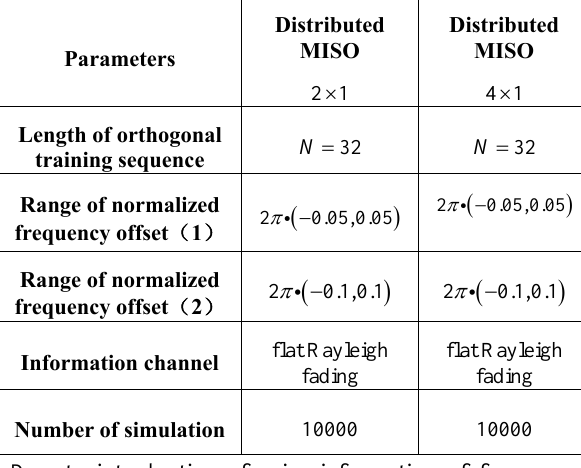
Distributed Distributed MISO MISO 2 1 × 4 1 × 32 N = 32 N =